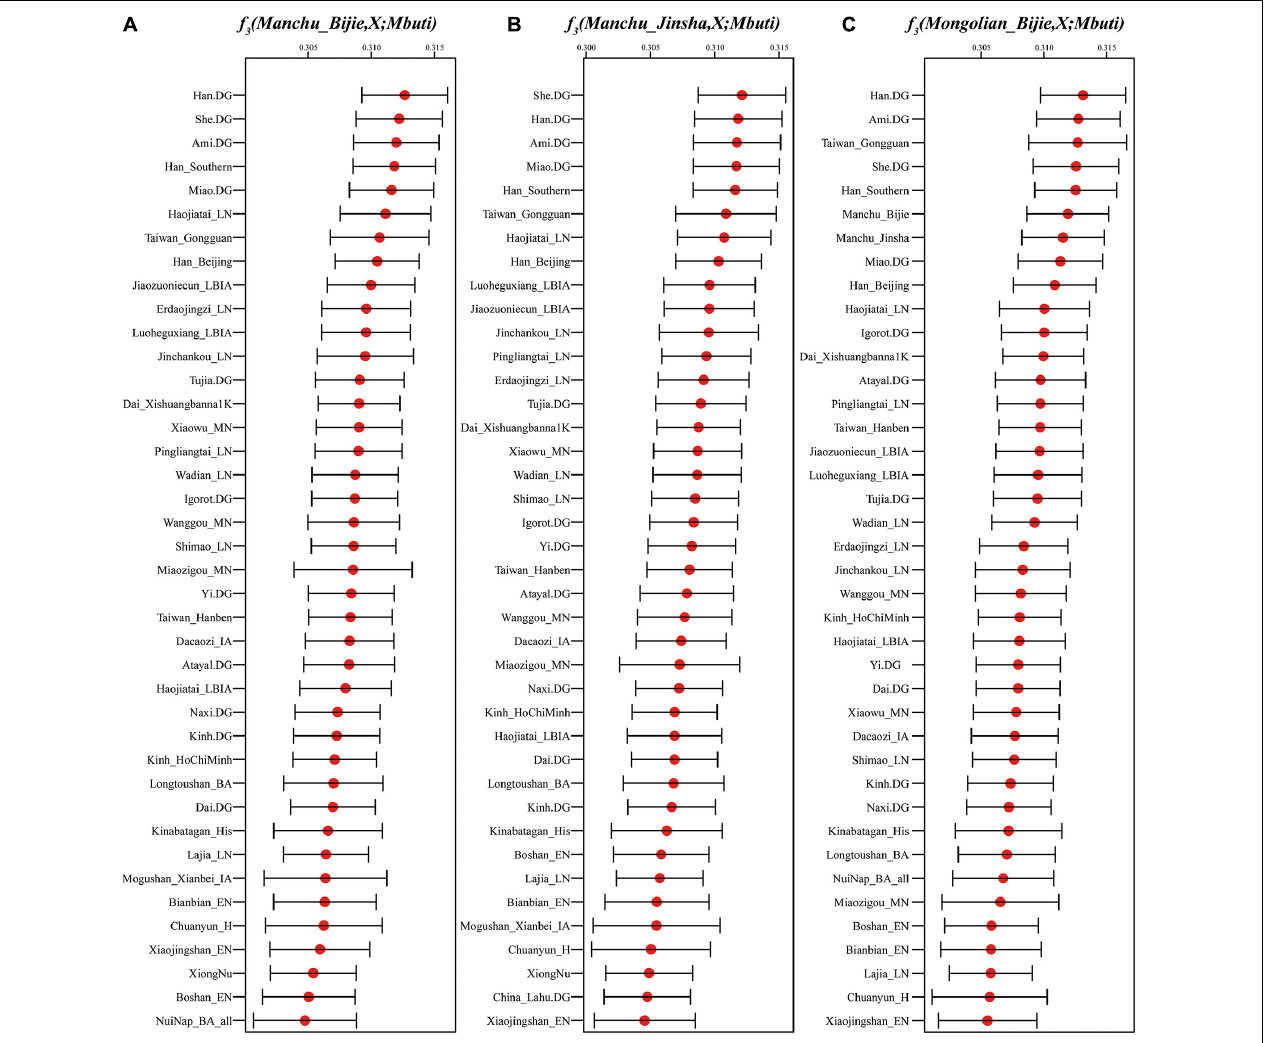
FIGURE 3 | Shared genetic drift estimated via admixture- f 3 statistics in different testing forms based on the merged 1240K dataset focused on Bijie Manchus (A) , Jinsha Manchus (B) , and Bijie Mongolians (C) . Bar denotes the three times of error